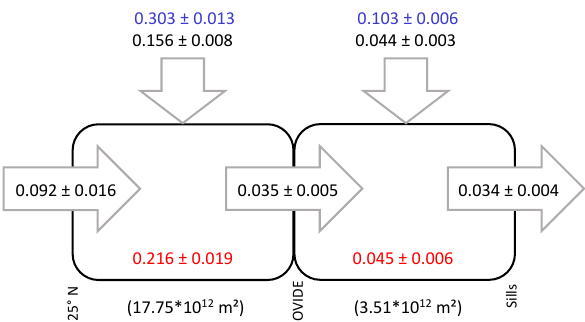
Figure 3. Anthropogenic C budget of the North Atlantic Subtropical and Subpolar regions over the period 2003–2011. Average values and their standard deviations were estimated from smoothed time series. Horizontal arrows show total Cant transport inPgCyr − 1 (black font). Red numbers indicate Cant storage rate inPgCyr − 1 . Vertical arrows show the air–sea fluxes of total (blue font) and an- thropogenic (black font) CO 2 in PgCyr − 1 . Boundaries and surface area (m 2 ) of each box are indicated below the